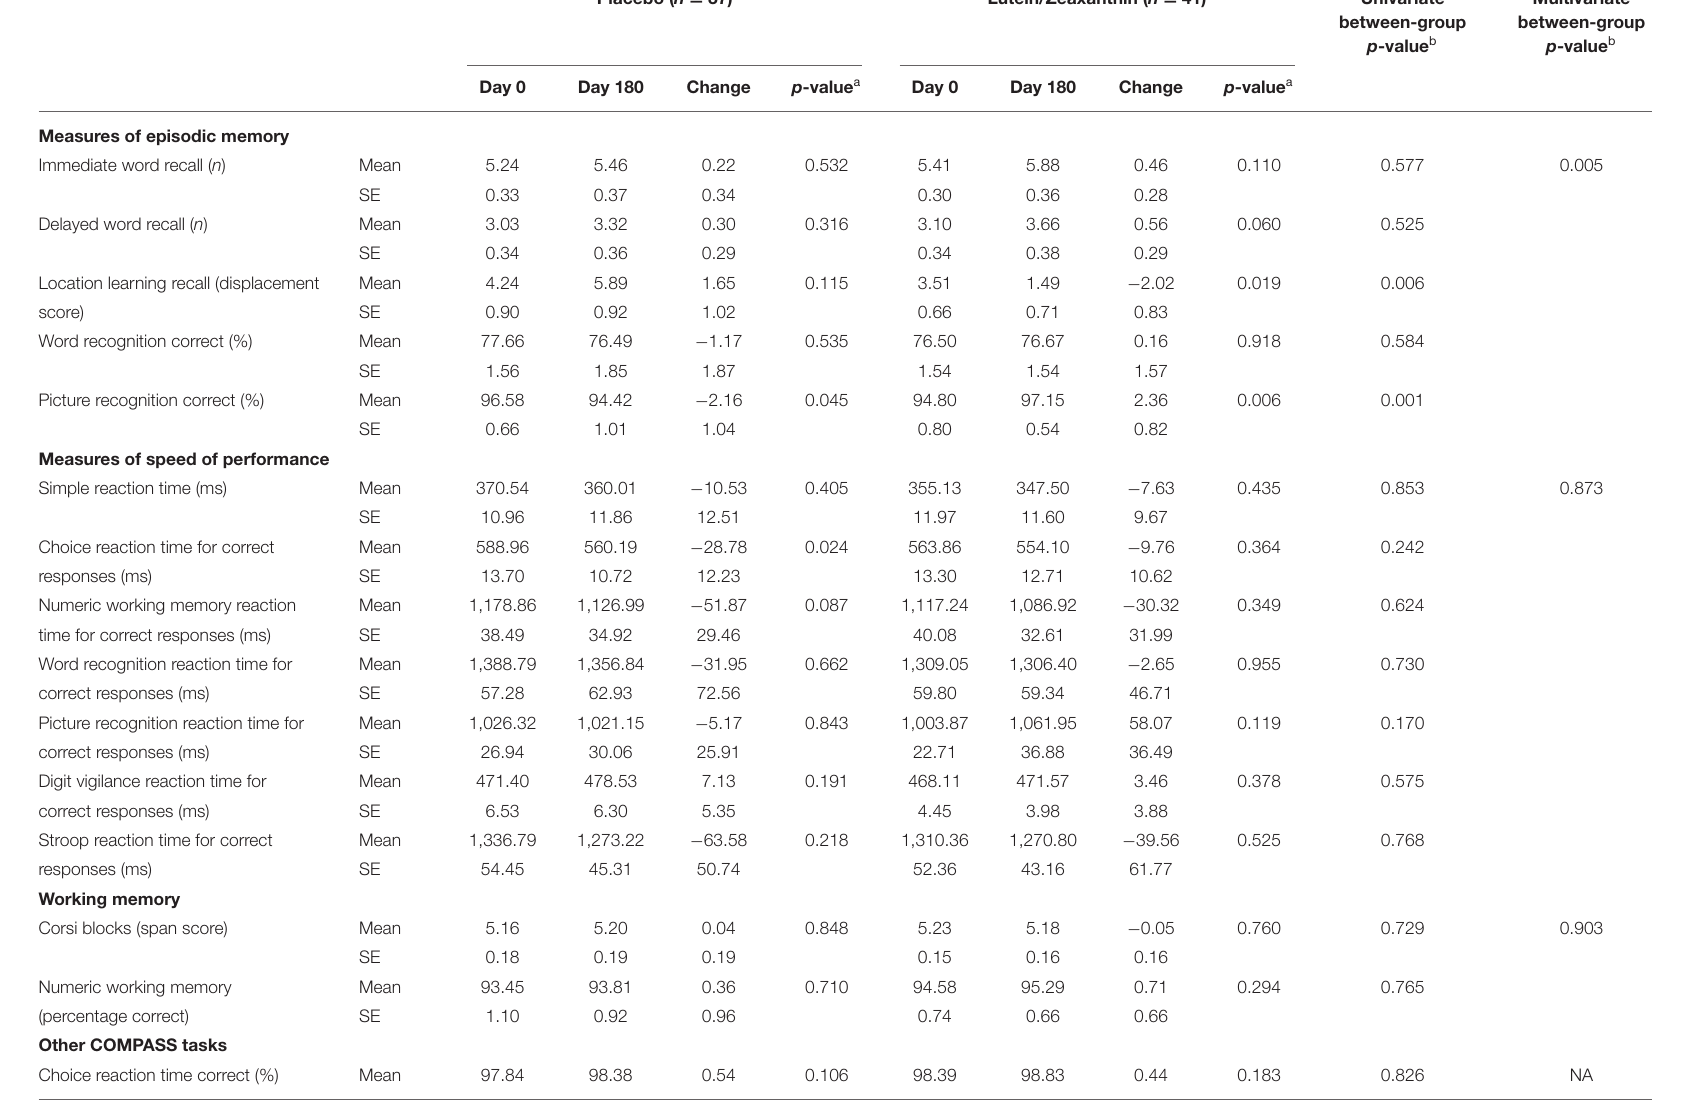
TABLE 4 | Change in COMPASS tasks. Placebo ( n = 37) Lutein/Zeaxanthin ( n = 41) Univariate